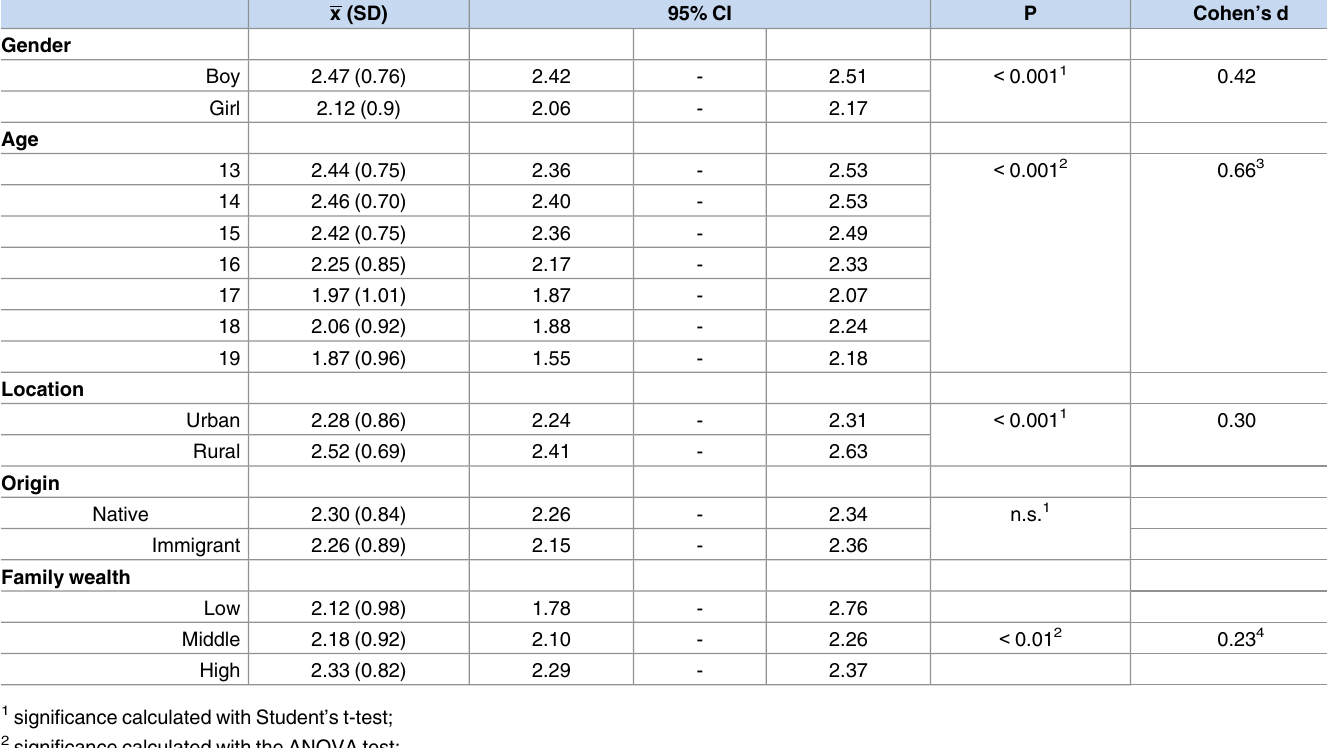
Table 5. Descriptiveanalysis of the physical activity component with respect to the different factors.